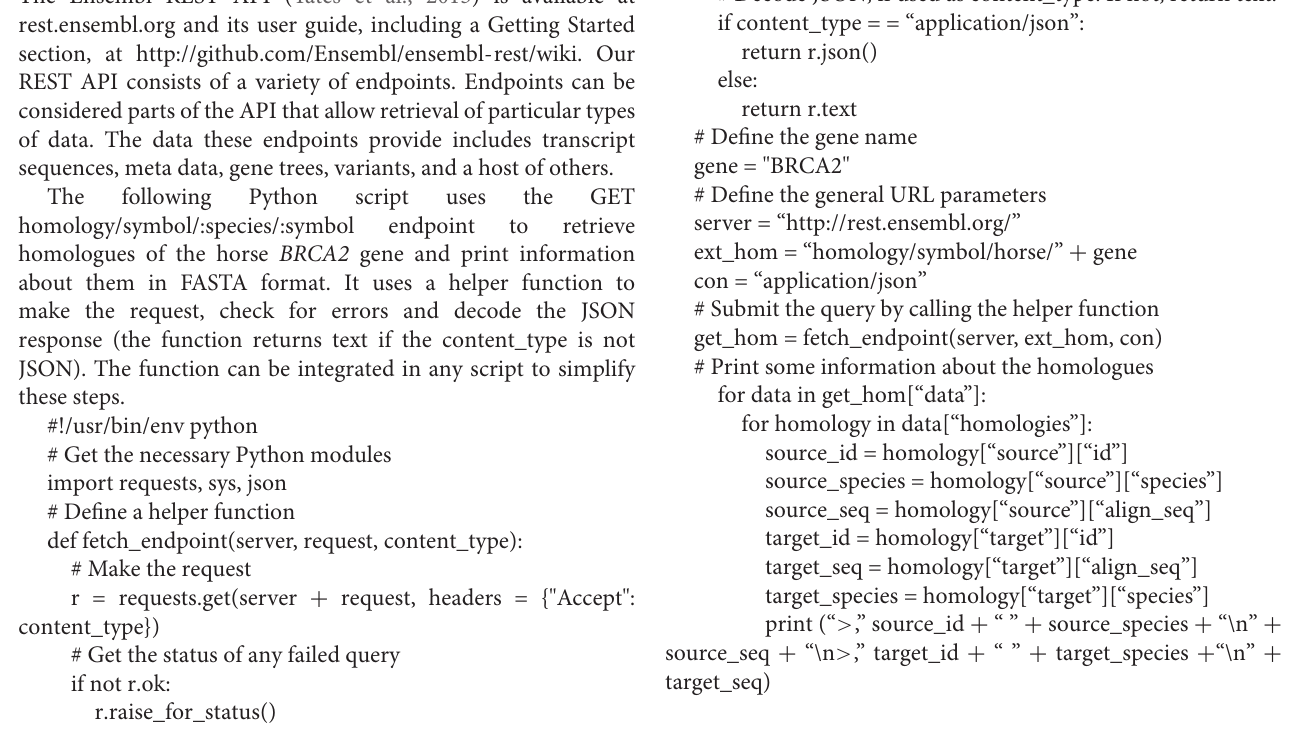
REST API: Retrieving Homologues of a Horse